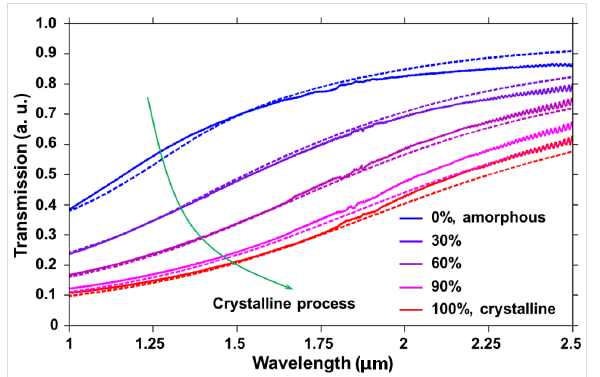
Figure 2: Comparison between the experimental spectra measure- ments (solid lines) and the simulated far-field transmission spectra (dashed lines) of a GST thin film switched at different intermediate phases. A good agreement of the spectral results shows the quantifi- able phase-change modulation of a GST nano thin film at different crystalline